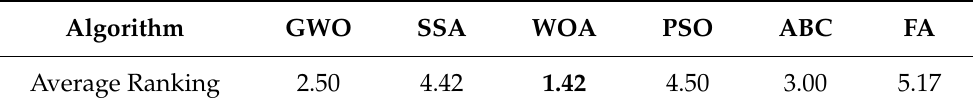
Table 4. Numerical results obtained by Friedman test (highest ranking is indicated in